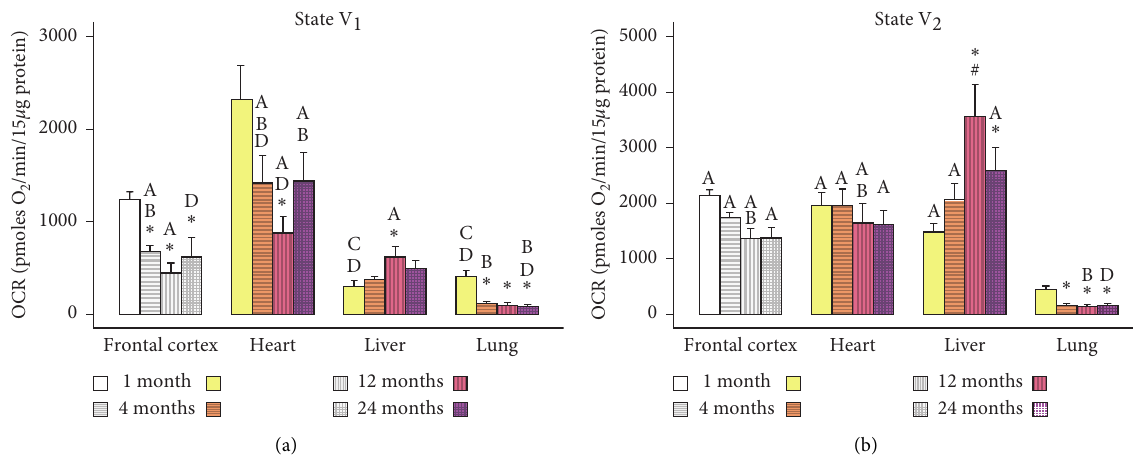
Figure 2: Age-dependent changes in State V 1 (a) and State V 2 OCR rates (b) in different organs. Values are expressed as means ± SEM from n � 5-6 observations/group. The differences between pairwise comparisons were considered statistically significant at p < 0 . 05. ∗ Significantly different from 1M rats; A significantly different from lung; B significantly different from liver; C significantly different from heart; D signi- ficantly different from frontal cortex; SEM, standard error of the mean. Grey-scale bars represent frontal cortex data from our previous report (adapted from Pandya et al. [23], with